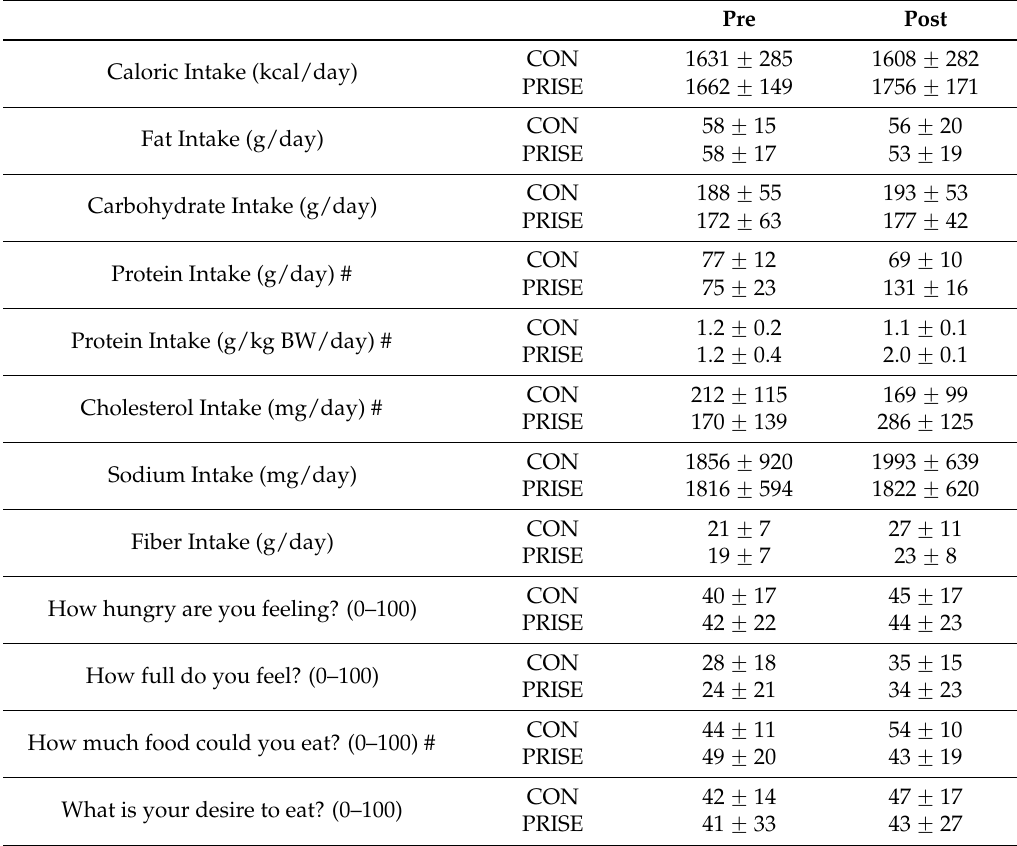
Table 3. Diet, satiety, and hunger ratings pre- and post-intervention.